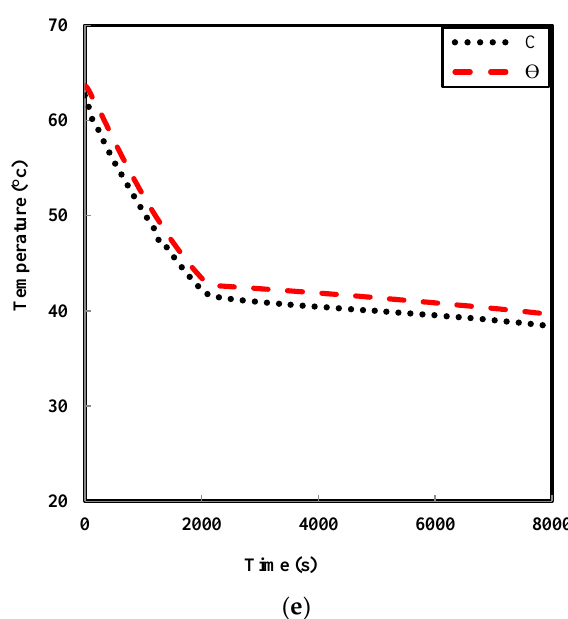
Figure 8. Scheme of experimental discharging temperature evolutions plotted as a function of the axial position versus time (23 °C), ( a ) thermocouples in radius of 6 mm, ( b ) thermocouples in radius of 13 mm, ( c – e ) temperature comparison of the thermocouples in 6 mm and 13 mm